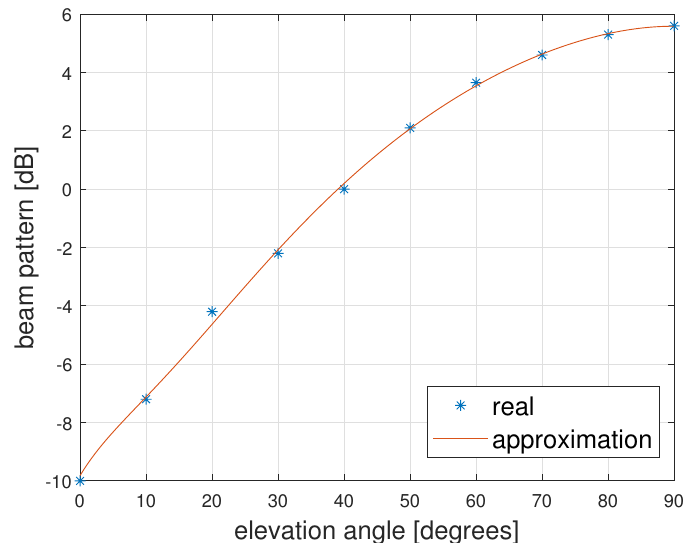
Figure 5. Approximation of the elevation beam pattern for a single high-frequency band antenna (HBA), for f c = 240 MHz created with a 4th order